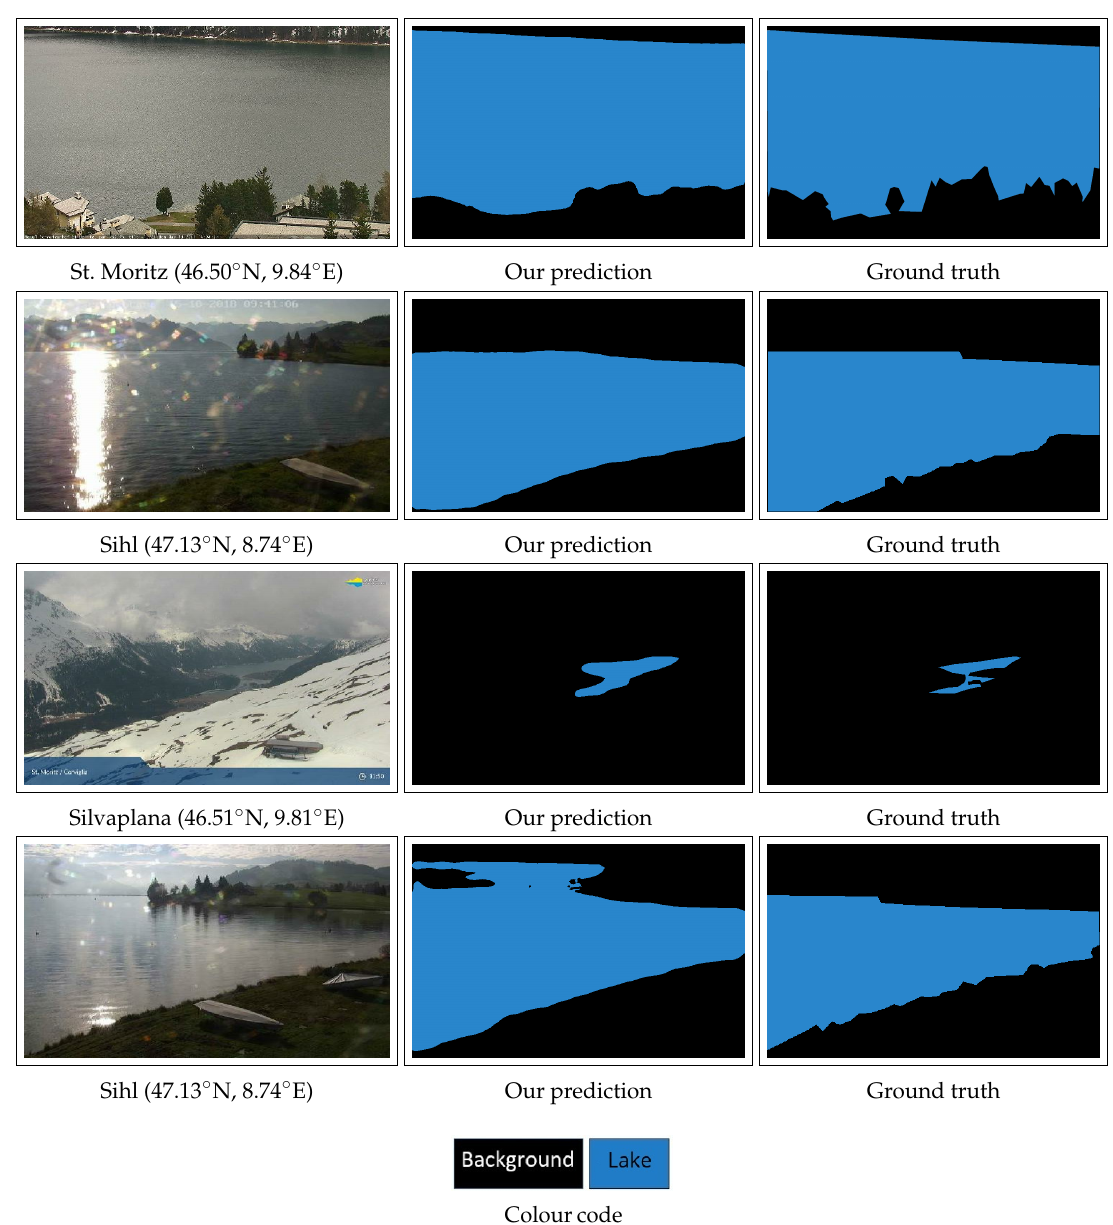
Figure 15. Lake detection results. Both success (rows 1,2,3) and failure (row 4) cases are shown. The colour code used to visualise the results is also displayed. The first column shows the lakes being monitored, along with the approximate location (latitude, longitude) of the